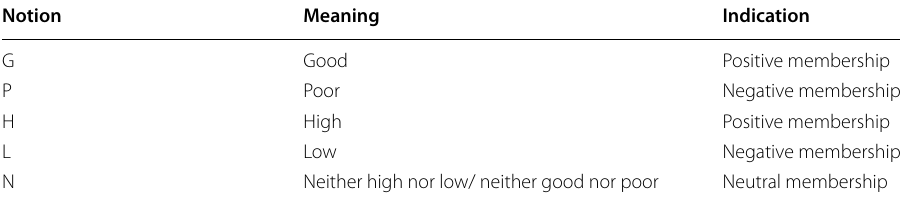
Table 7 Linguistic evaluation scale for the alternatives